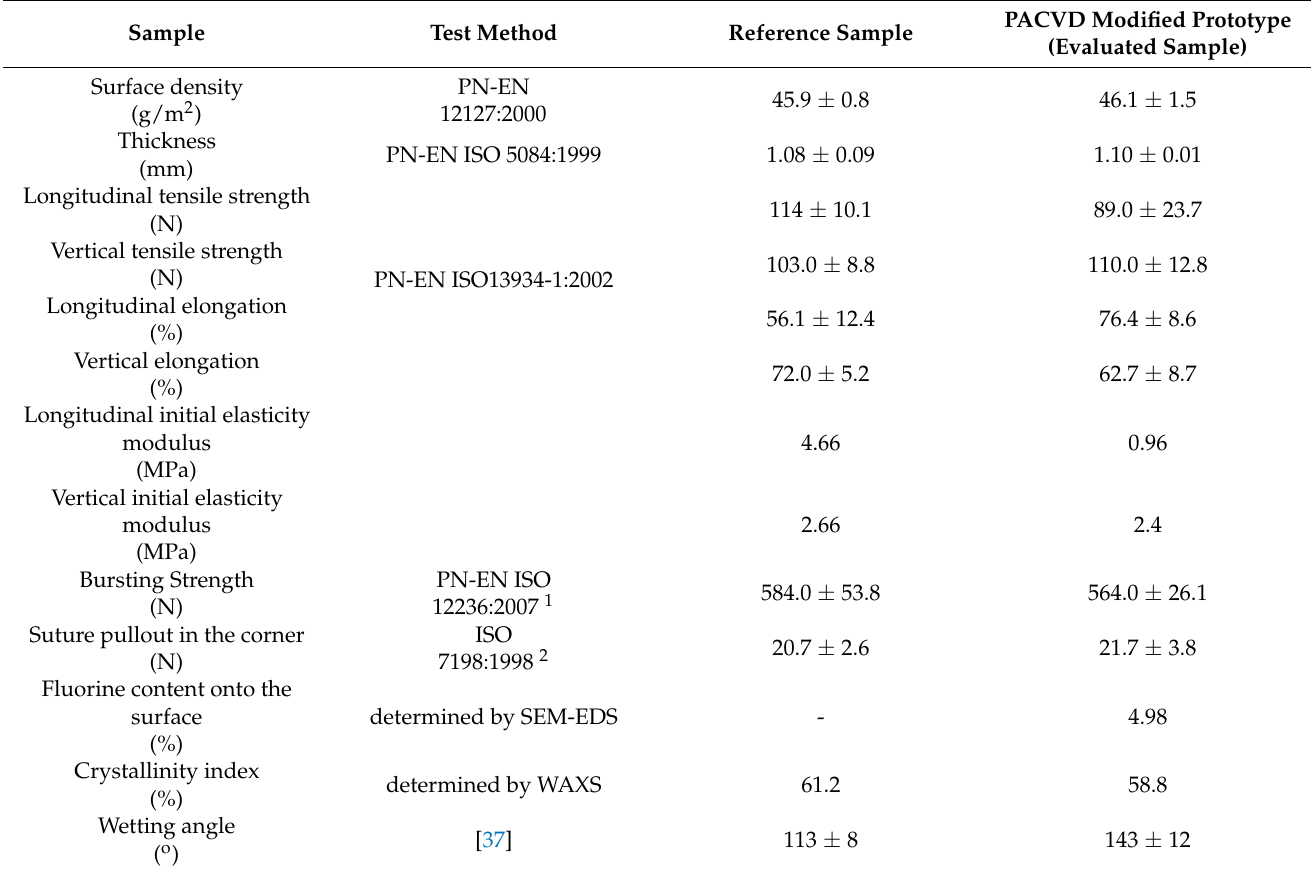
Table 1. Physiochemical properties of the reference and the studied